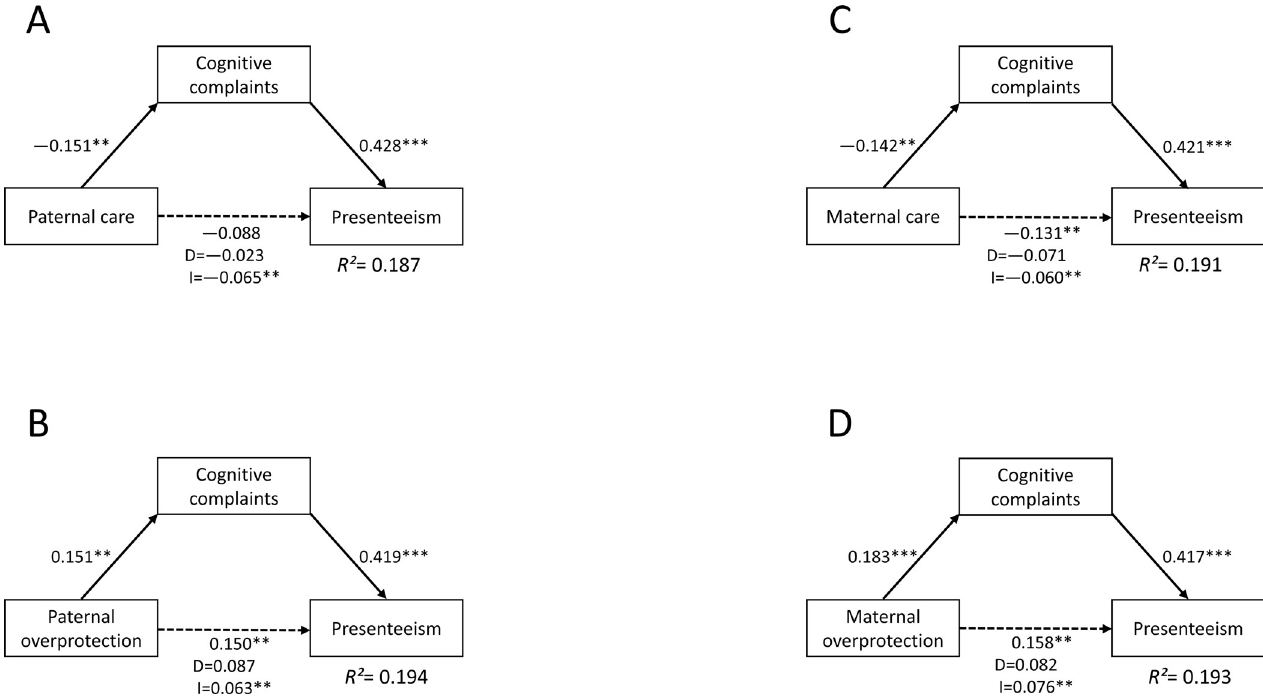
Fig 2. The mediating effect of cognitive complaints on the relationship between childhood parental bonding and presenteeism in non-psychiatric adult workers (N = 390). D, direct effect; I, indirect effect; R 2 , coefficient of determination. Relationships between childhood parental bonding, CCs, and presenteeism are demonstrated using path analyses. A) Paternal care directly affected CCs, and CCs directly affected presenteeism. B) CCs fully mediated the impact of paternal overprotection on presenteeism. C) CCs fully mediated the impact of maternal care on presenteeism. D) CCs fully mediated the impact of maternal overprotection on presenteeism. The numbers beside the arrows demonstrate the standardized path coefficients of total effects. The numbers below the total effect of parental bonding on presenteeism demonstrate the direct (D) and indirect (I) effects. The solid line demonstrates a significant direct effect, and the dotted line demonstrates a non-significant direct effect. Parental bonding demonstrates PBI sub-scores; CCs demonstrate COBRA total score; and presenteeism demonstrates WLQ work productivity loss